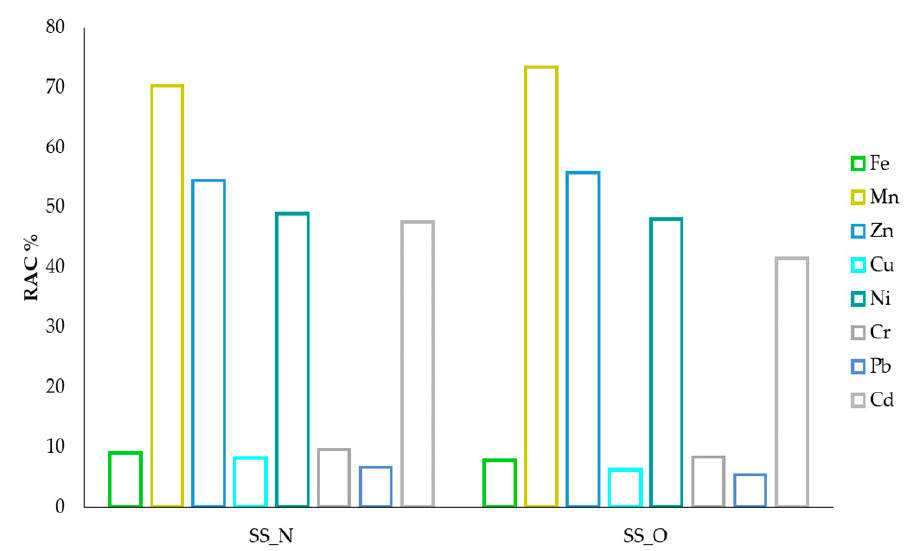
Figure 3. Risk assessment code (RAC) for sewage sludge used in the experiment. <1 no risk; 1–10 low risk; 11–30 medium risk; 30–50 high risk; >50 very high risk [16,26,27]